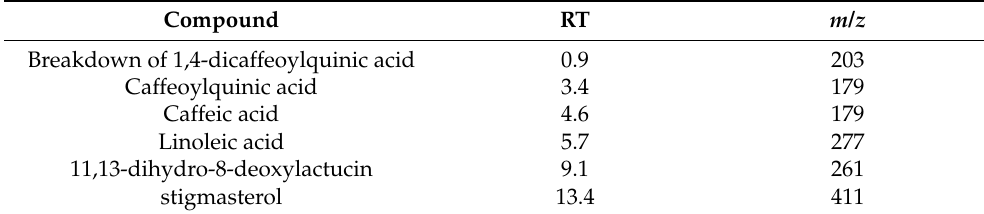
Table 1. Table with identification of compounds present in the extracts using LC/MS. Compound RT m / z Breakdown of 1,4-dicaffeoylquinic acid